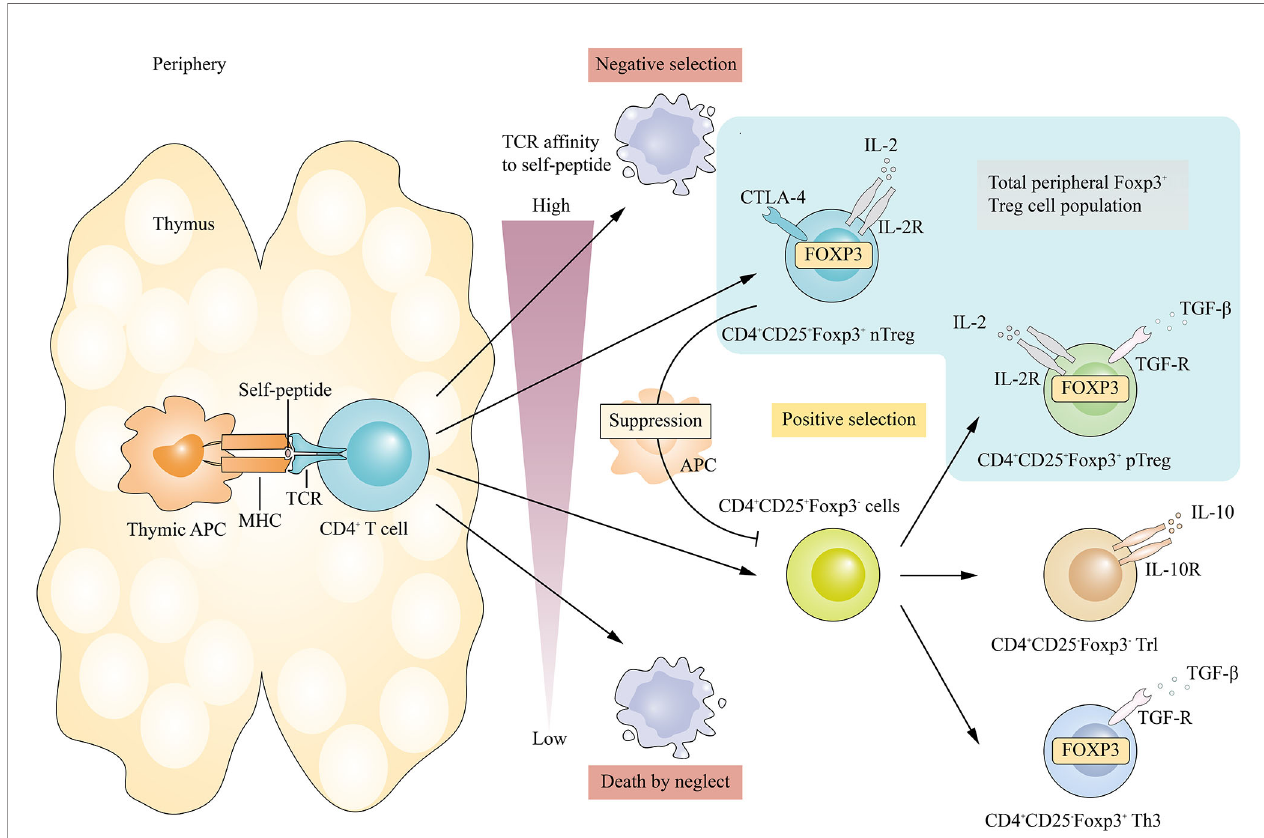
FIGURE 2 | Differentiation of Treg cells in vivo . TTreg cell development is initiated by TCR signal transduction. CD4+CD8- thymocytes that bind with high af fi nity to their self- peptides-MHC complex are positively selected in the thymus. Immature T cells with low af fi nity for their own peptide-MHC complex are also positively selected and subsequently differentiated into different subtypes, including pTreg, Tr1 and